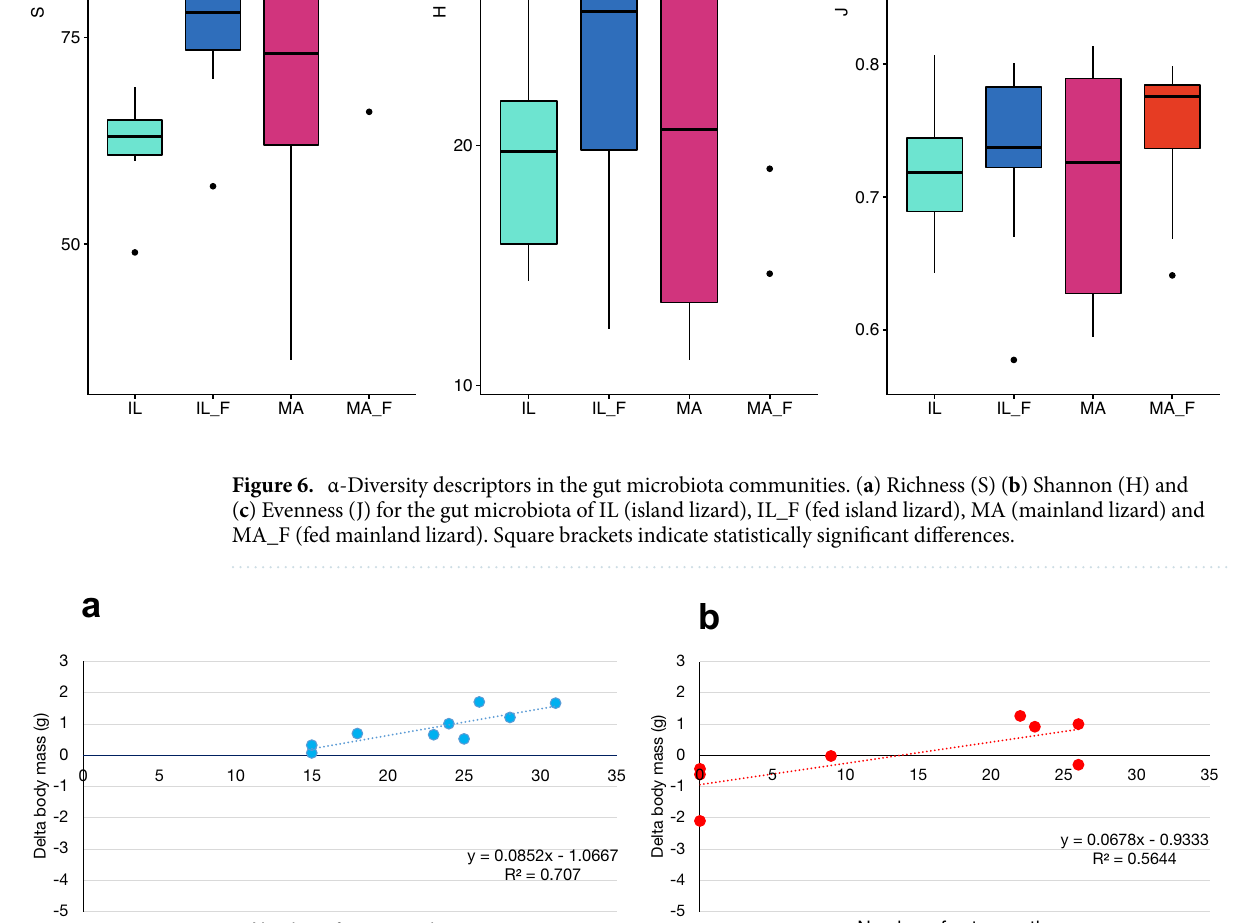
Figure 7. Weight increase after food suppling. Correlation between the number of ingested moths and weight change (g) in ( a ) island and ( b ) mainland lizard